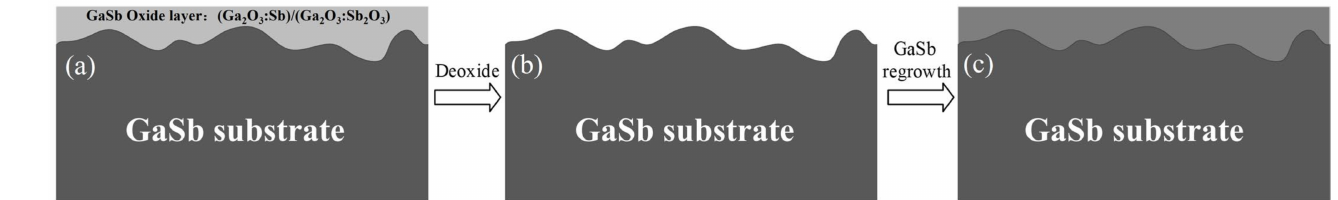
Figure 4. Deoxidation and uniform regrowth process of GaSb substrate with native oxide layer. ( a ) Schematic of a GaSb substrate surface with a native oxide layer. ( b ) Schematic diagram of the surface of a deoxidized GaSb substrate. ( c ) Schematic diagram of GaSb substrate surface after deoxidation and epitaxy of GaSb buffer